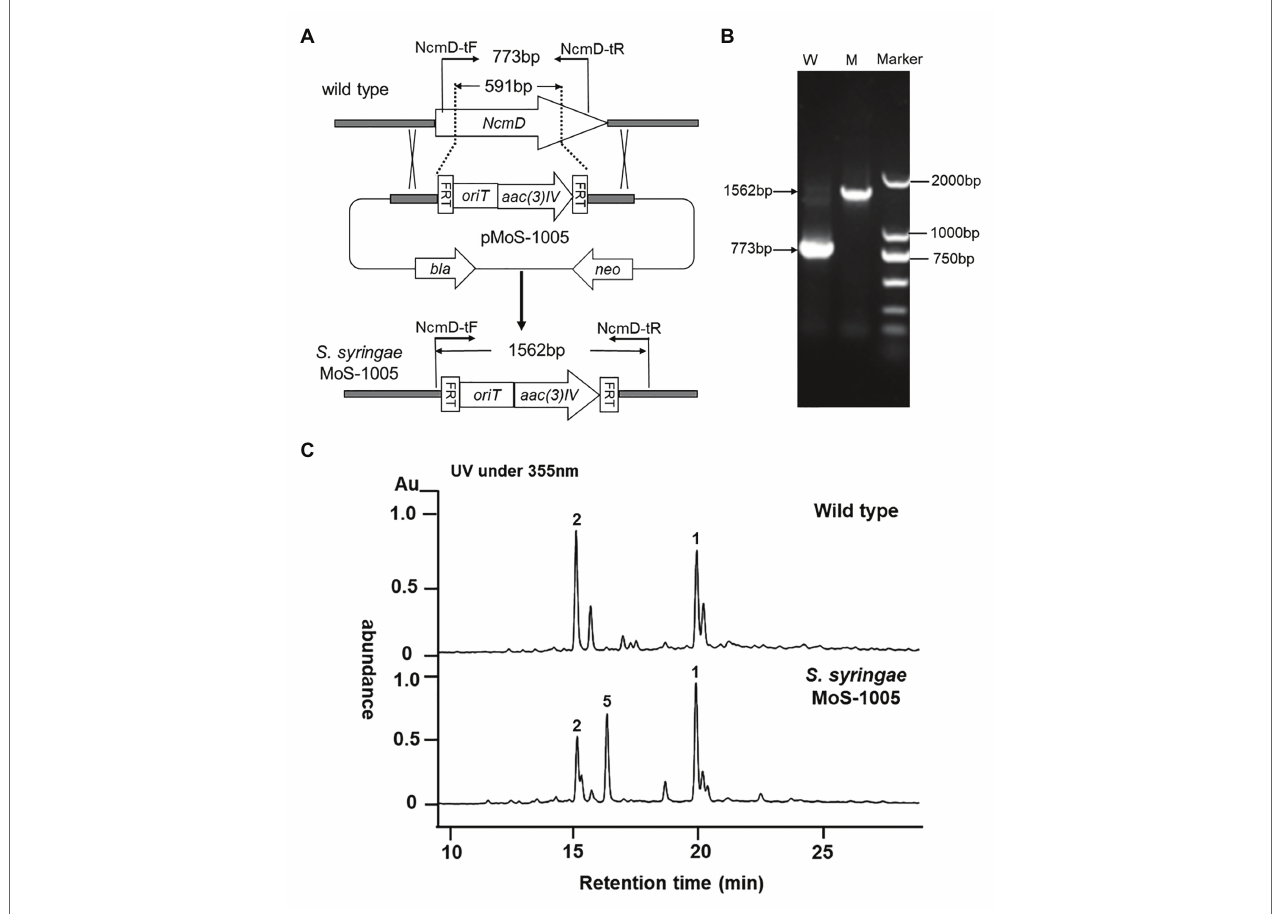
FIGURE 3 | Generation of ΔNcmD mutant strain Saccharothrix syringae MoS-1005 and its metabolites profile analyzed by HPLC. (A) Schematic diagram of NcmD inactivation. The 591 bp internal NcmD fragment was replaced by oriT and acc3(IV) fragment in pMoS-1005. (B) PCR analysis of the double-crossover mutant S. syringae MoS-1005. W: S. syringae wild type (773 bp); M: mutant strain S. syringae MoS-1005 (1,562 bp); Marker: DNA molecular ladder. (C) Metabolite profiles of S. syringae MoS-1005 analyzed by HPLC. 1: nocamycin I, 2: nocamycin II, 5: the newly produced